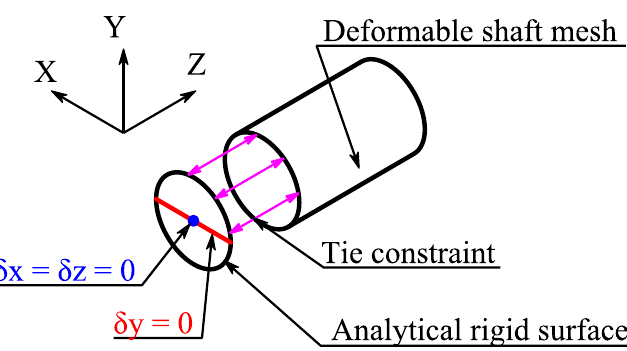
Figure 3. Boundary conditions of the 3-D finite element shaft model.